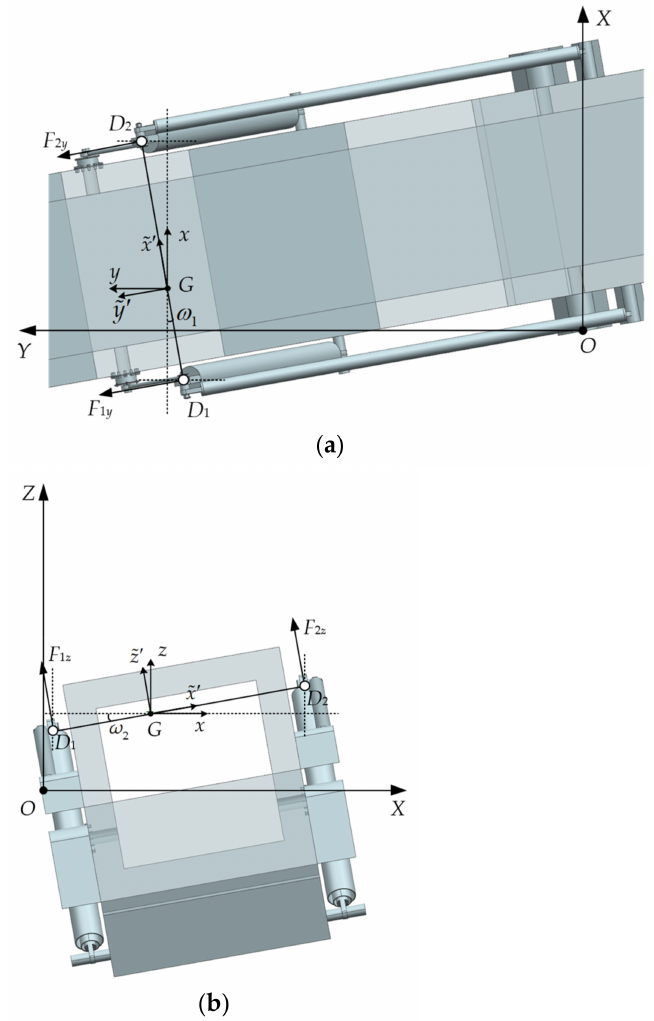
Figure 6. Motion analysis diagram of the unbalanced rotation. ( a ) Projection of rotation on plane Gxy , ( b ) Projection of rotation on plane Gxz